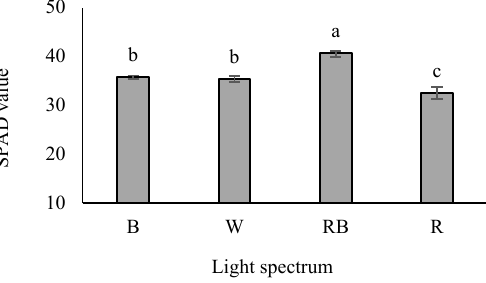
Figure 6. SPAD values in grafted tomato seedlings exposed to different light qualities (including white (W; 35% B, 49% intermediate spectra, 16% R) light as control, blue (B), red (R), and a combination of red (68%) and blue (RB), (see the correspondence spectrum in Figure 1)), with 75 ± 5 µ mol m − 2 s − 1 PPFD for 20 days. Columns with the same letters are not significantly different at p ≤ 0.05, according to Duncan’s multiple range tests. Bars represent the mean value of three replications ± SEM.